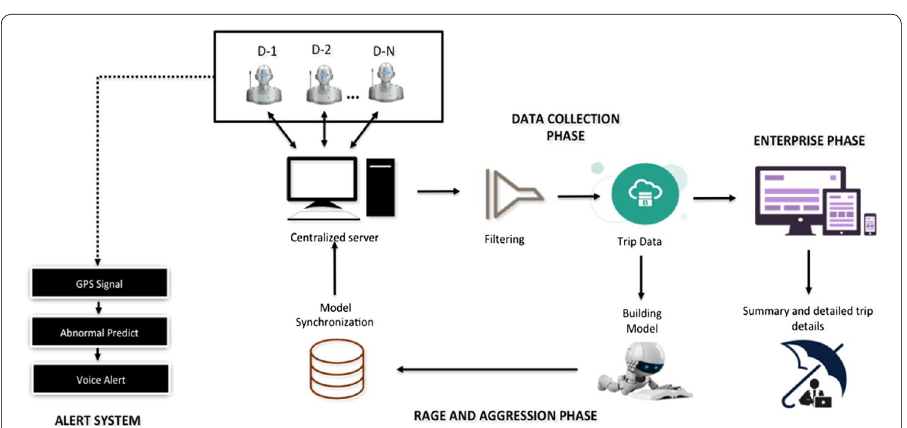
Fig. 7 Proposed solution for personalized premium